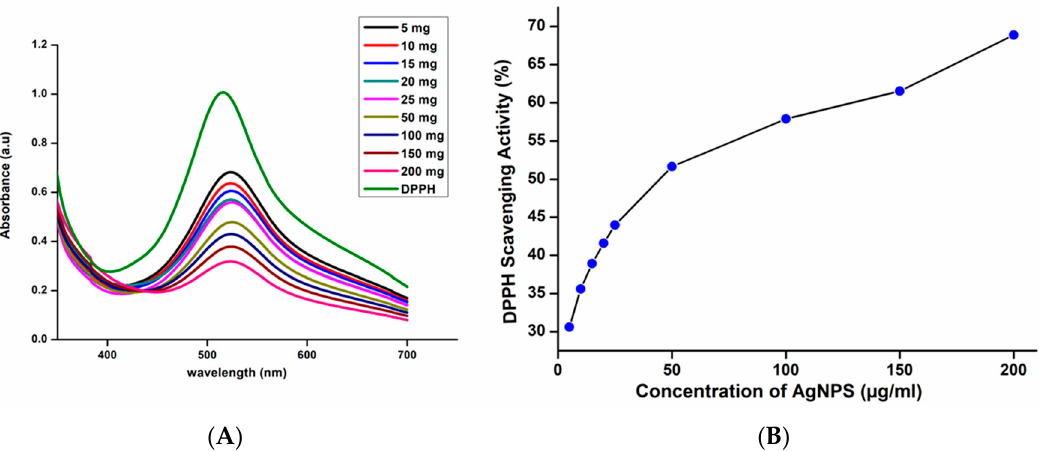
Figure 4. ( A ) UV–Visible spectra of DPPH with different concentrations of AgNPs ( B ) DPPH scavenging activity of AgNPs.